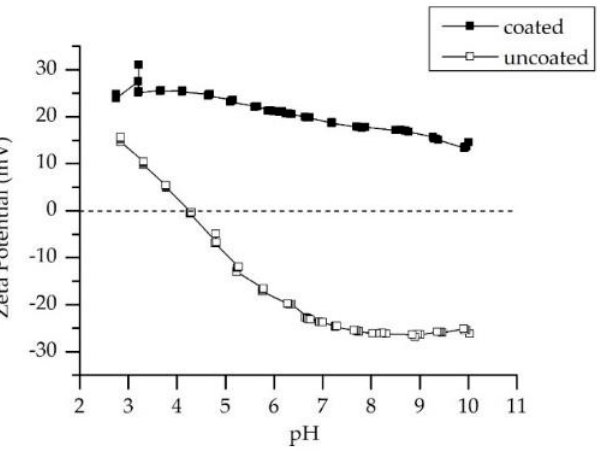
Figure 9. Zeta potential as a function of pH for an alumina ceramic membrane and LbL-coated alumina ceramic membrane.